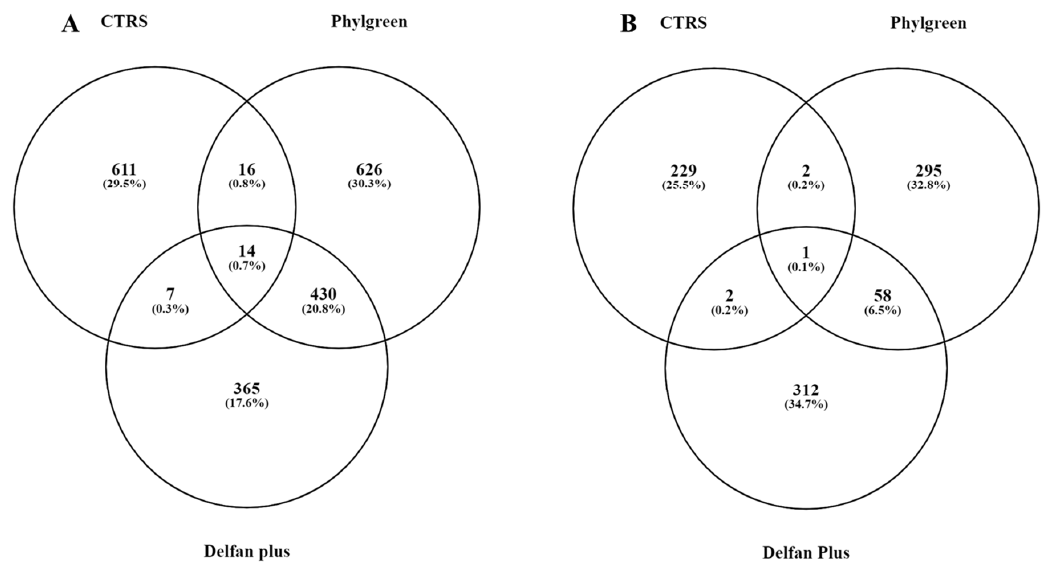
Figure 1. Common and specific differentially expressed genes (FC > 2) in stressed control (CTRS) and treated plants (Phylgreen and Delfan Plus) grouped by the Venn diagram. ( A ) Upregulated DEGs and ( B ) downregulated DEGs.